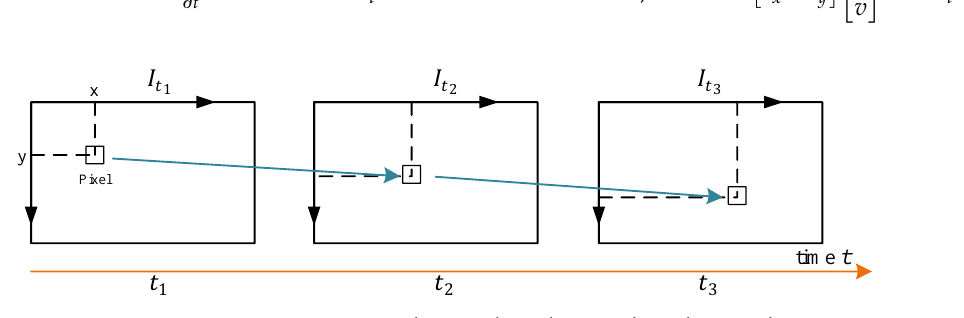
Figure A1. LK optical flow algorithm schematic diagram. I t y are the pixel coordinates of the corresponding feature point, and I ( x , y , t ) represents the gray value of the image frame at pixel coordinates ( x , y ) at time t